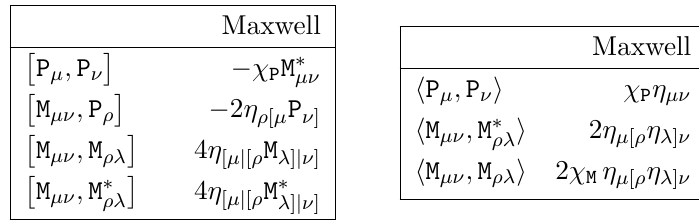
Table 5 . The double extension of the Poincar(cid:19)e algebra is the Maxwell algebra. We have lowered the indices of M (cid:3) (cid:22)(cid:23) by (cid:17) (cid:22)(cid:23) . The invariant metric is nondegenerate for (cid:31)